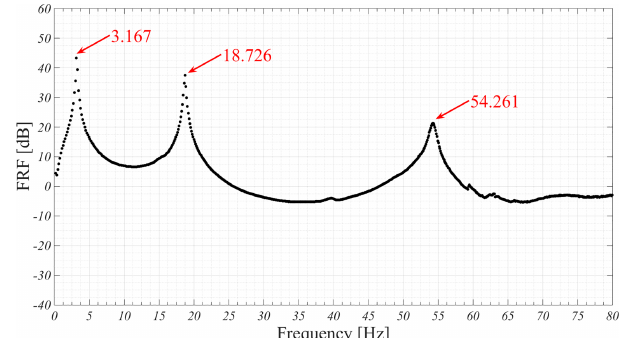
Table 1. Eigen-Frequencies of tower